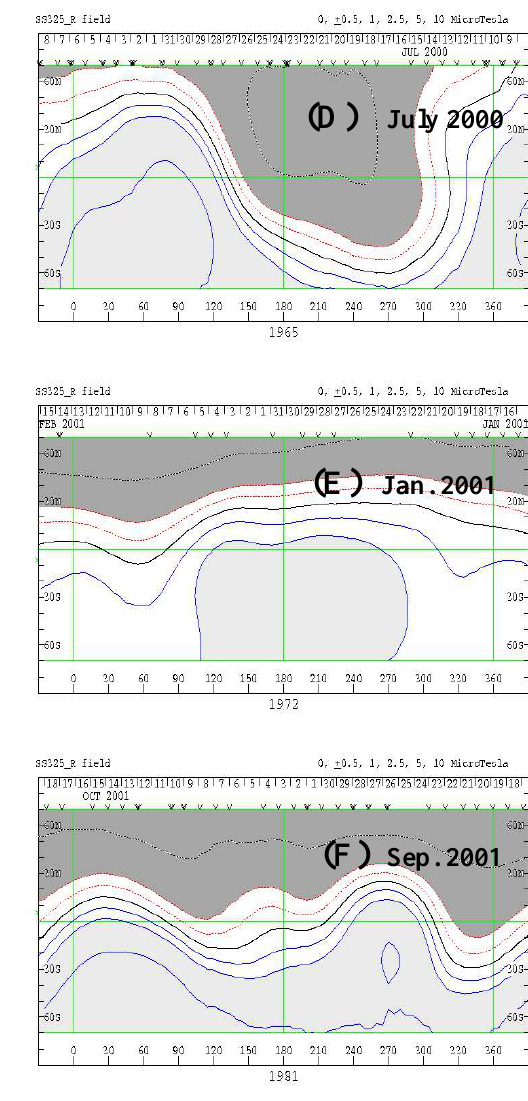
Fig. 10. Configuration of the solar magnetic field as calculated by Hoeksema for a source surface at 3.25 solar radii for the first (left) and second (right) fast latitude